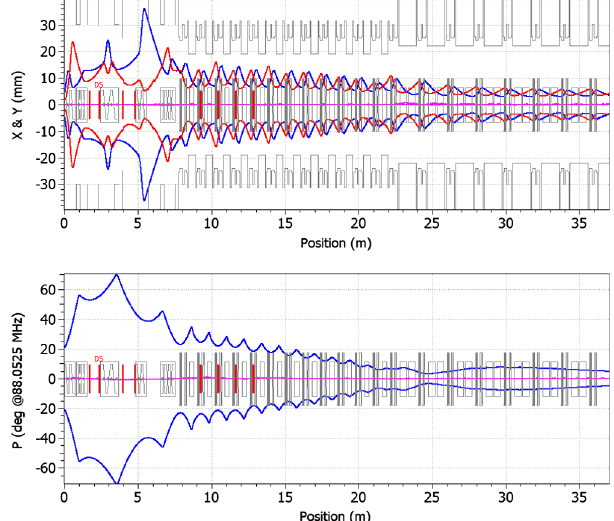
FIG. 5. Three rms envelopes from multiparticle simulation for the reference proton